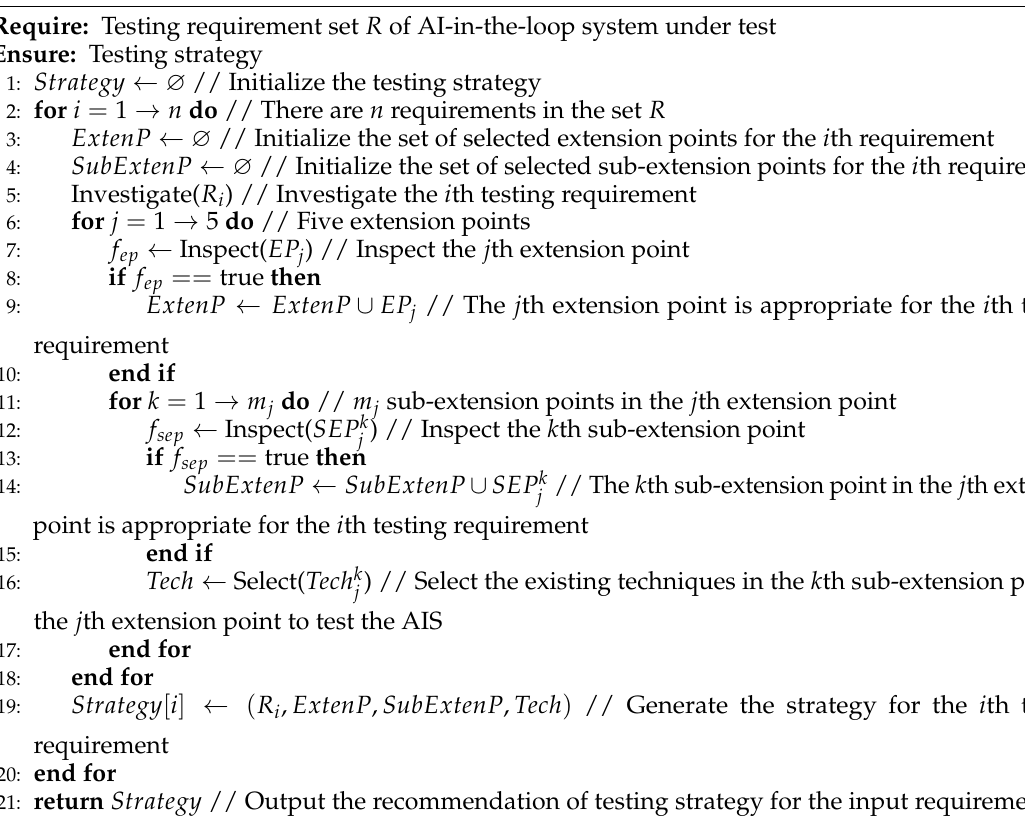
Algorithm 1 Execution steps of testing AI-in-the-loop system in